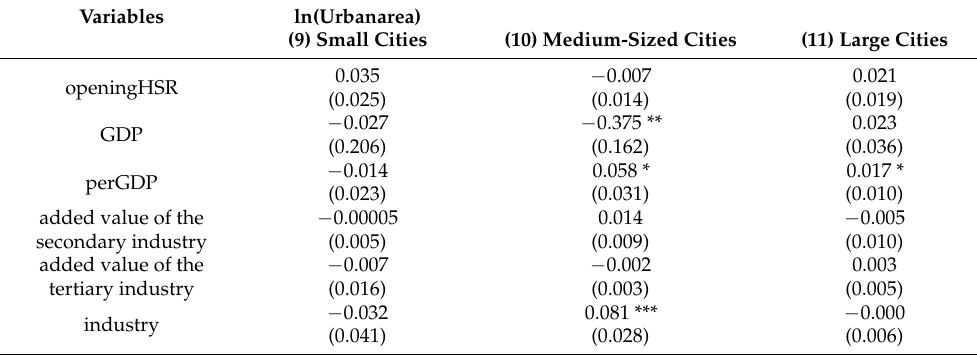
Table 4. The impact of HSR on urban expansion of the cities of different sizes in